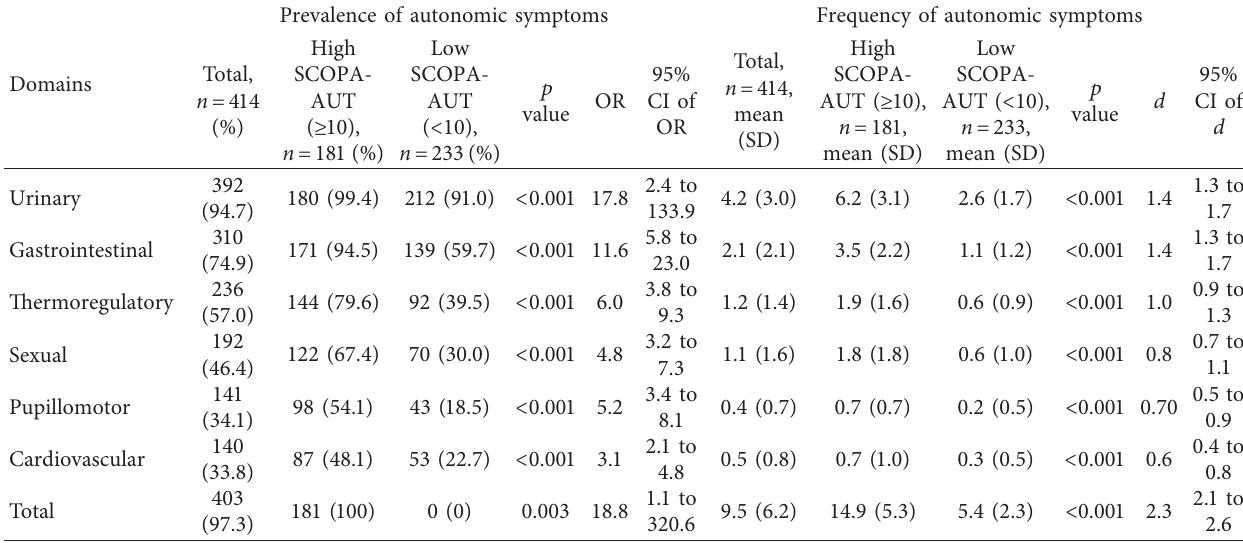
Table 1: Comparison of prevalence and frequency of autonomic symptoms between the high and low SCOPA-AUT groups of patients with